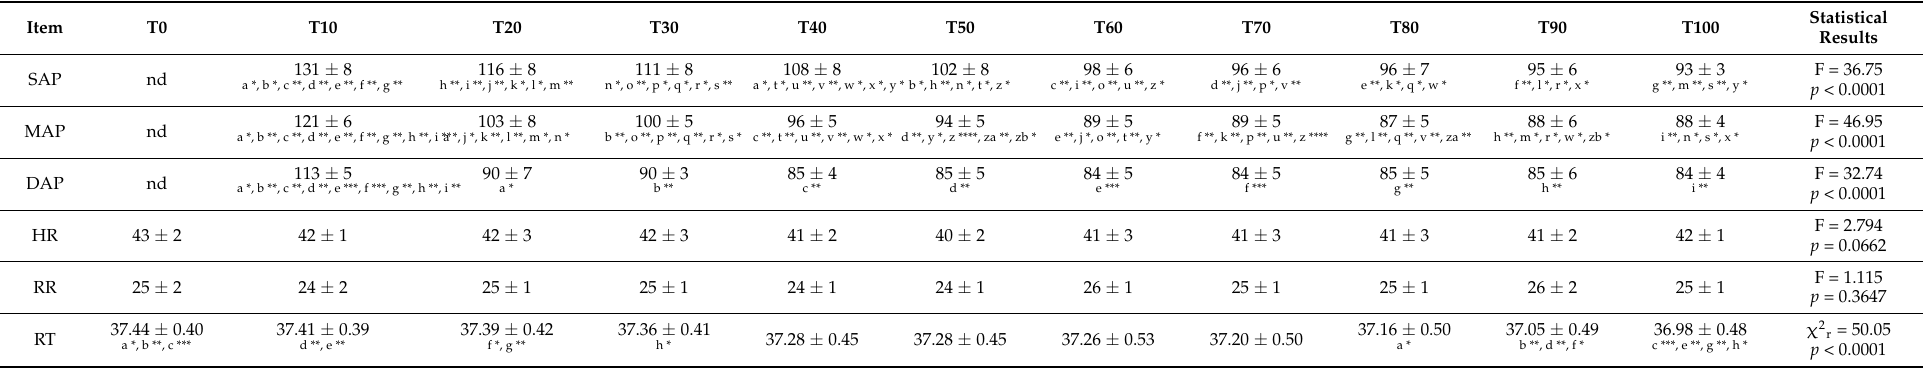
Table 3. Mean values ± standard deviation and longitudinal statistical results of invasive systolic (SAP), mean (MAP) and diastolic (DAP) arterial blood pressures (mmHg), heart rate (HR, beats/min), respiratory rate (RR, breaths/min) and rectal temperature (RT, ◦ C) during the study. Time points, T0: baseline; from T10 to T100: measurements from start of surgery until the end of surgery. nd: not determined. F: result of Anova F statistics (F-ratio); χ 2 r : result of Friedman statistics. For each parameter, the pairs of equal letters indicate the pairs of comparison between time points showing significant difference at post hoc multiple comparisons; asterisks indicate the level of significance at multiple comparisons, *: p < 0.05; **: p < 0.01; ***: p < 0.001; ****: p <